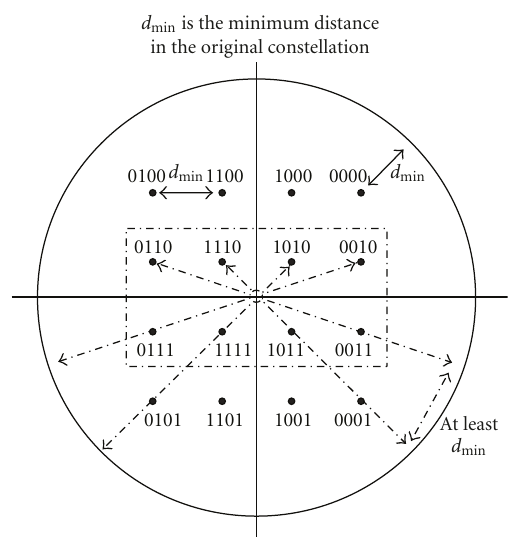
Figure 5: 16-ary QAM modulation with radial symmetric map-